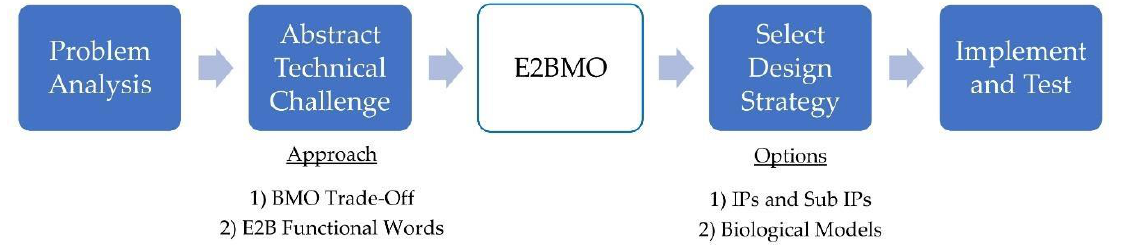
Figure 9. Illustration of the simplified biomimicry process through use of the E2BMO website.